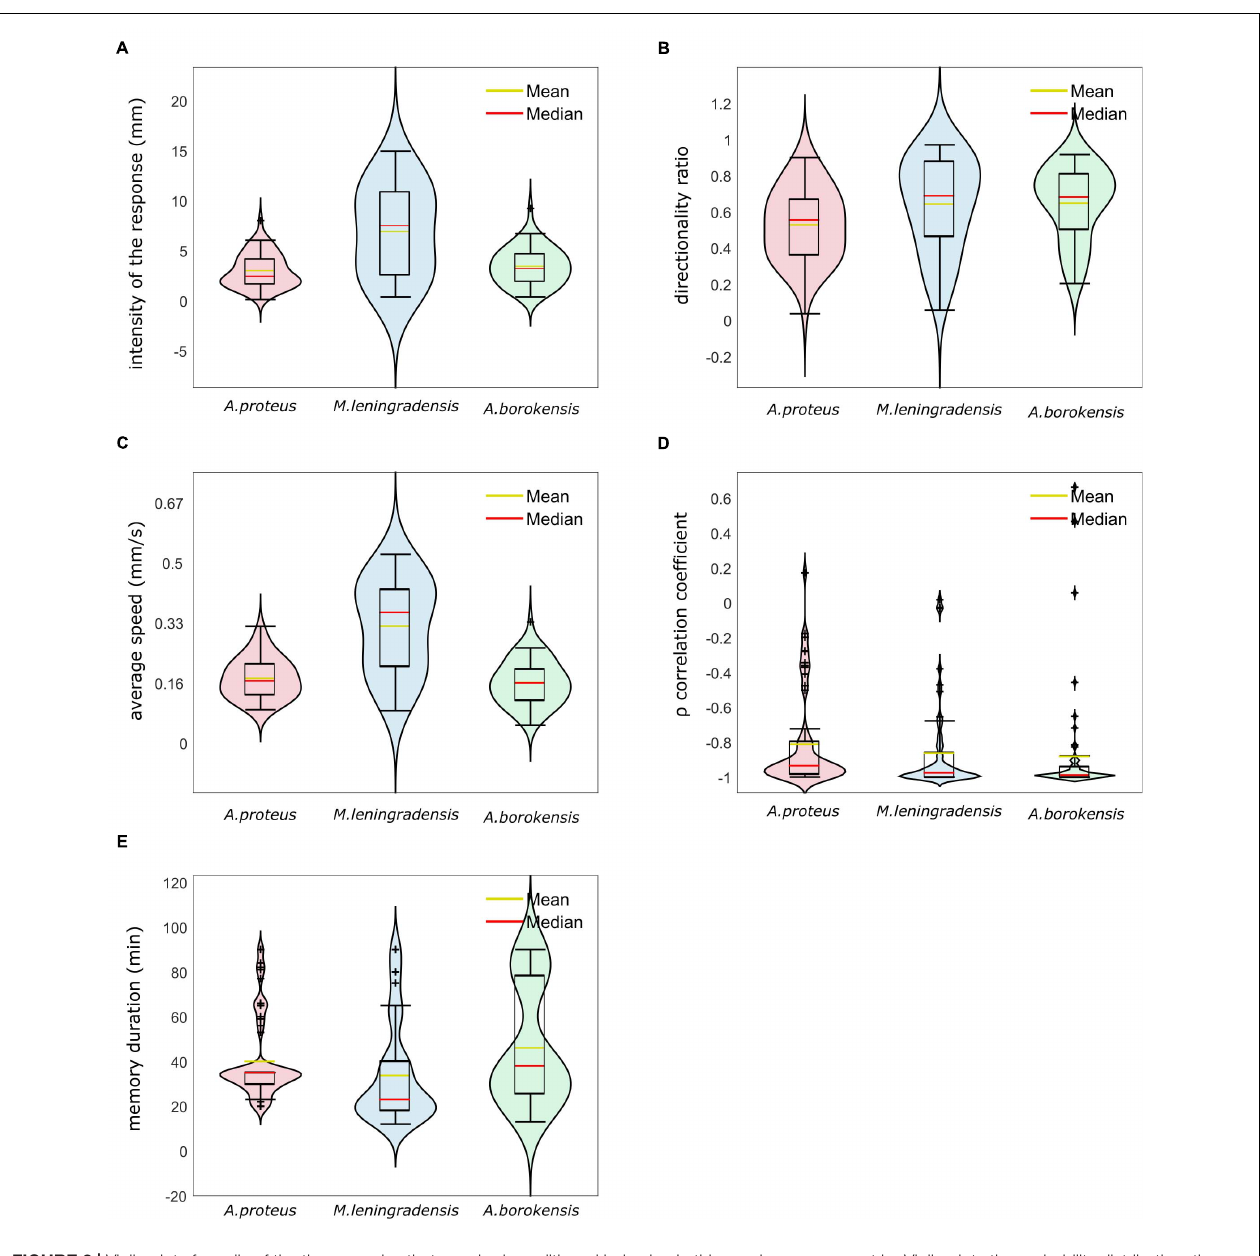
FIGURE 8 | Violin plots for cells of the three species that acquired conditioned behavior. In this graph, we represent by Violin plots the probability distribution, the boxplots, and the mean value of the five main quantitative characteristics. Panel (A) depicts the intensity of response (in mm), panel (B) illustrates the directionality ratio, panel (C) represents average speed (in mm/s), panel (D) depicts Spearman’s correlation coefficient between time and the x -axis of the trajectory, and (E) illustrates the persistence time of the acquired new behavior (mins). A. proteus cells presented conditioned responses characterized by strong persistence, less speed and less distance traveled than the other species. M. leningradensis were the less stable cells, i.e., demonstrated less homogeneity and more variability than the other species; additionally, this species showed more intensive and fast migration than the other two. A. borokensis cells exhibited more directionality persistence than the other two species, with high straightness toward the anode. The three species analyzed show extremal values in their correlation coefficient (close to -1), and it can be concluded that the cellular conditioning for the three species is a very robust behavior with strong directional